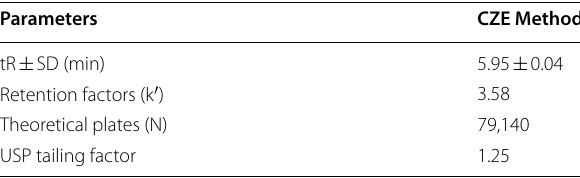
Table 1 System suitability parameters for TIG analysis